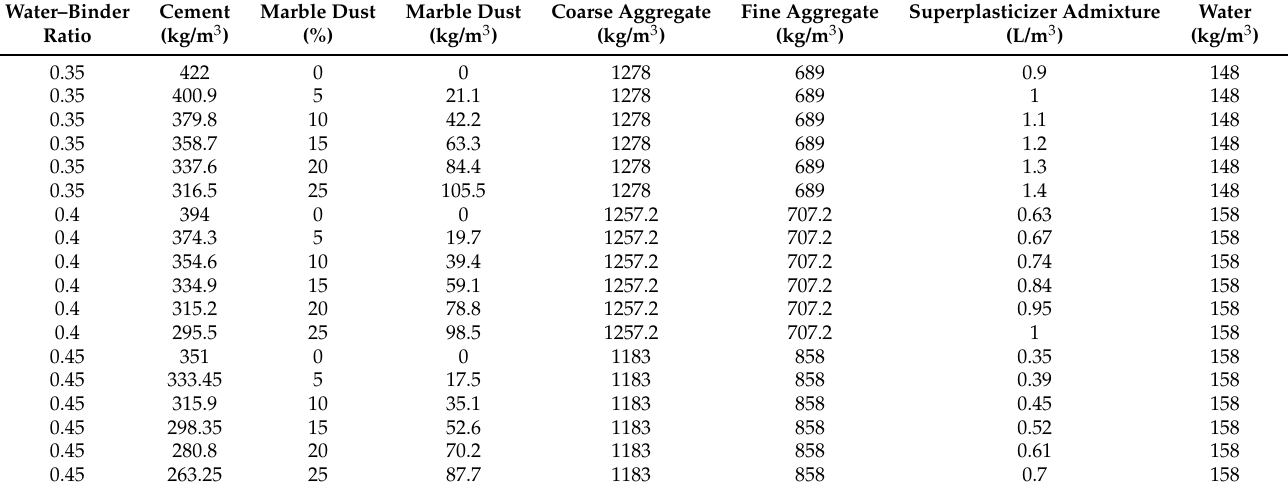
Table 2. Proportions of concrete